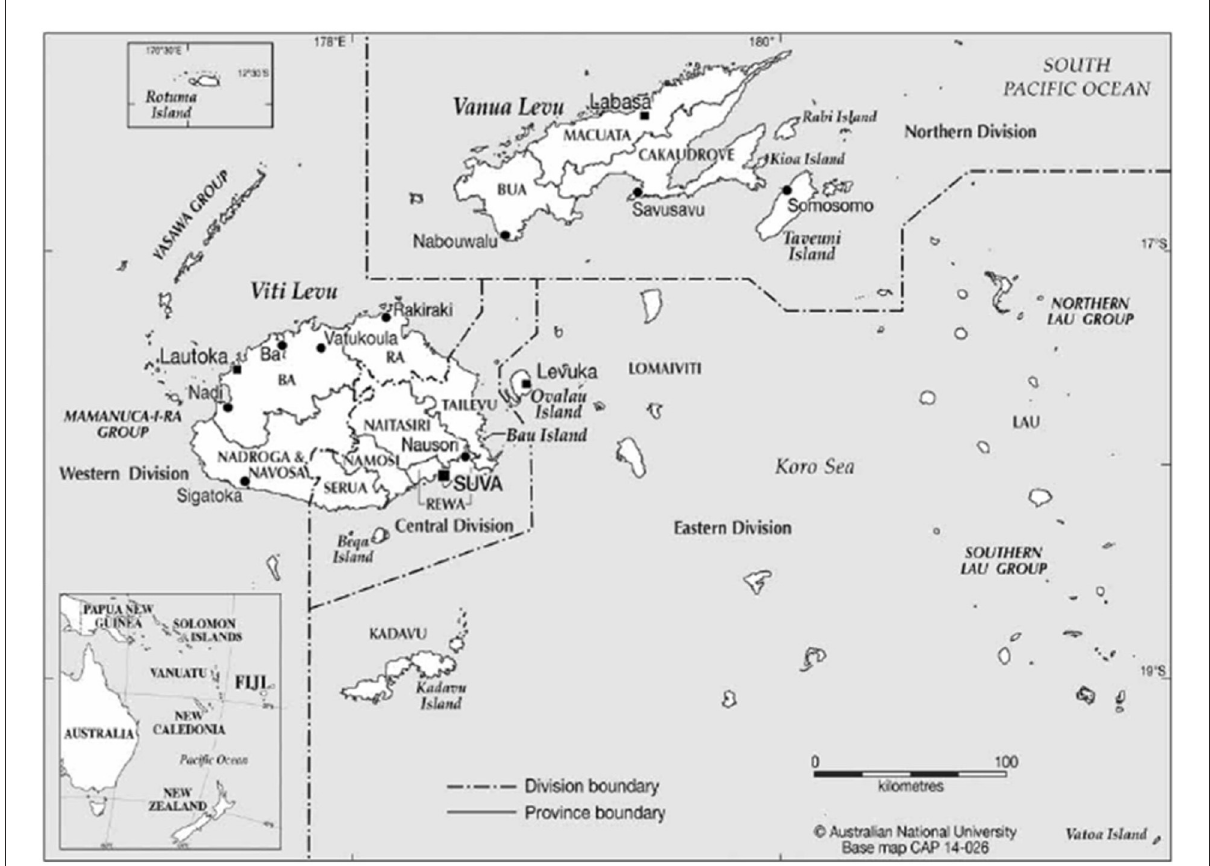
FIGURE2 Map of Fiji showing Division boundaries. Maps Online, CartoGIS Services, ANU College of Asia and the Pacific, The Australian National